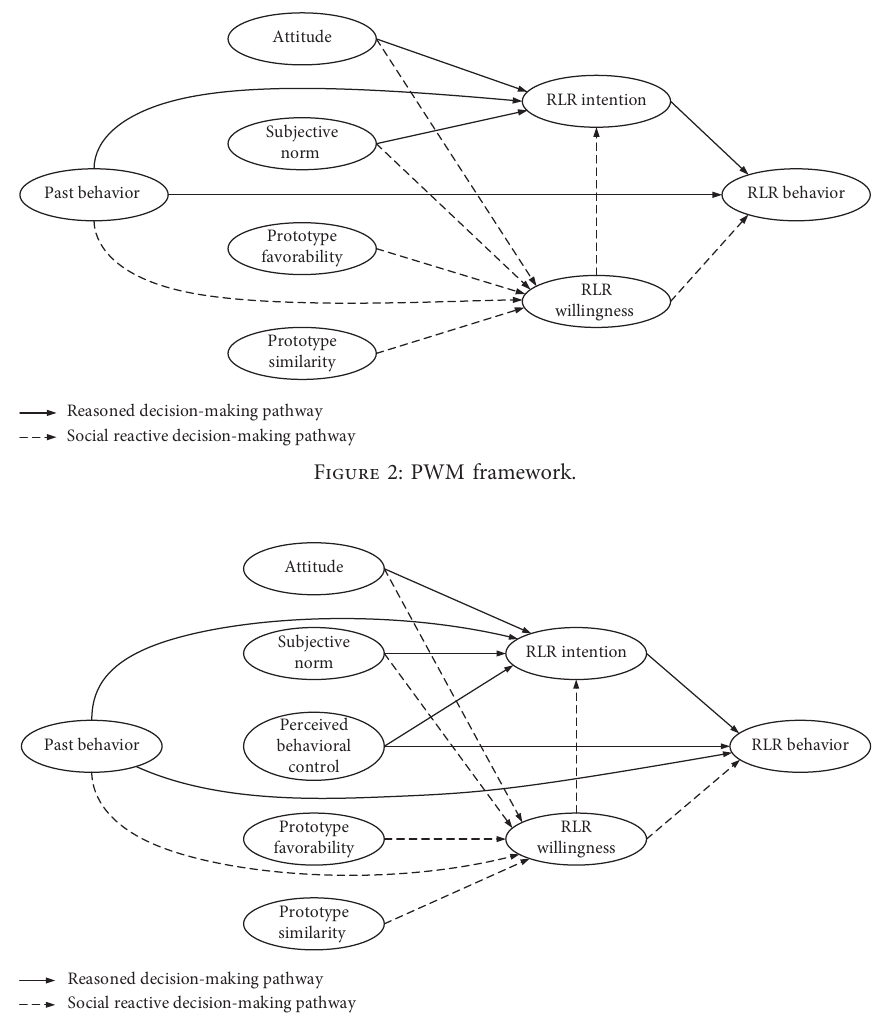
Figure 3: TPB-PWM framework.